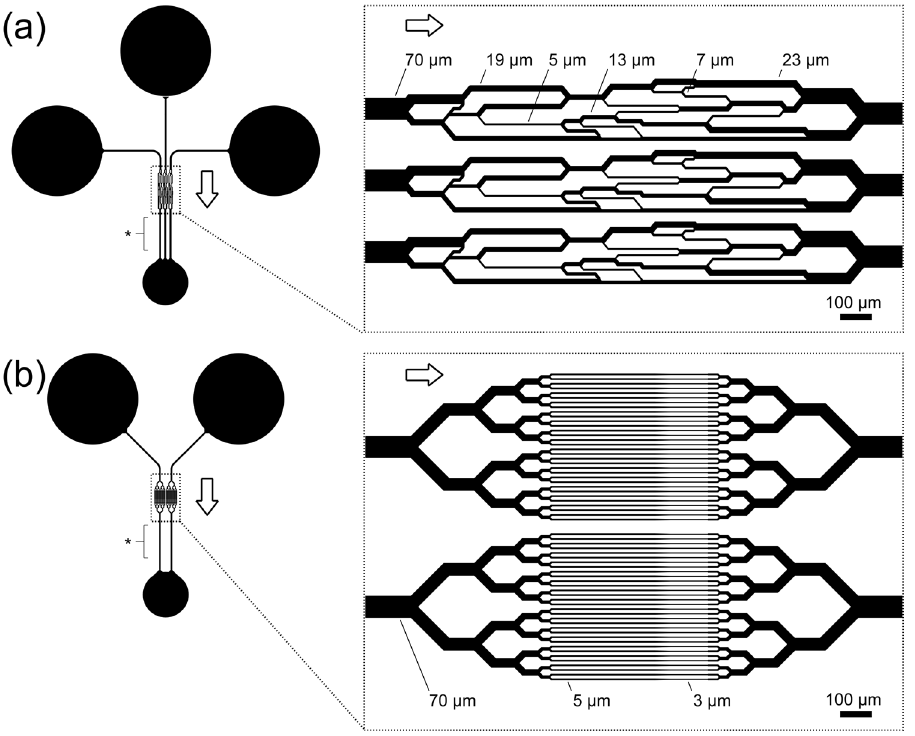
Figure 1. Schematic illustration of the microfluidic devices used to evaluate rheological properties of stored RBCs. ( a ) The artificial microvascular network (AMVN) device consisted of three parallel, identical networks of interconnected channels ranging in width from 70 µm to 5 µm. ( b ) The multiplexed microcapillary network (MMCN) device consisted of two parallel, identical networks of 32 microcapillaries, each narrowing in width from 5 µm to 3 µm. For both devices, each network unit had a separate inlet, and was connected to a shared outlet. All channels were approximately 5 µm deep. Arrows indicate the overall direction of flow in each device. Asterisks (*) indicate the sections of 70 µm wide outlet channels where images for perfusion rate measurements were acquired. Scale bars = 100